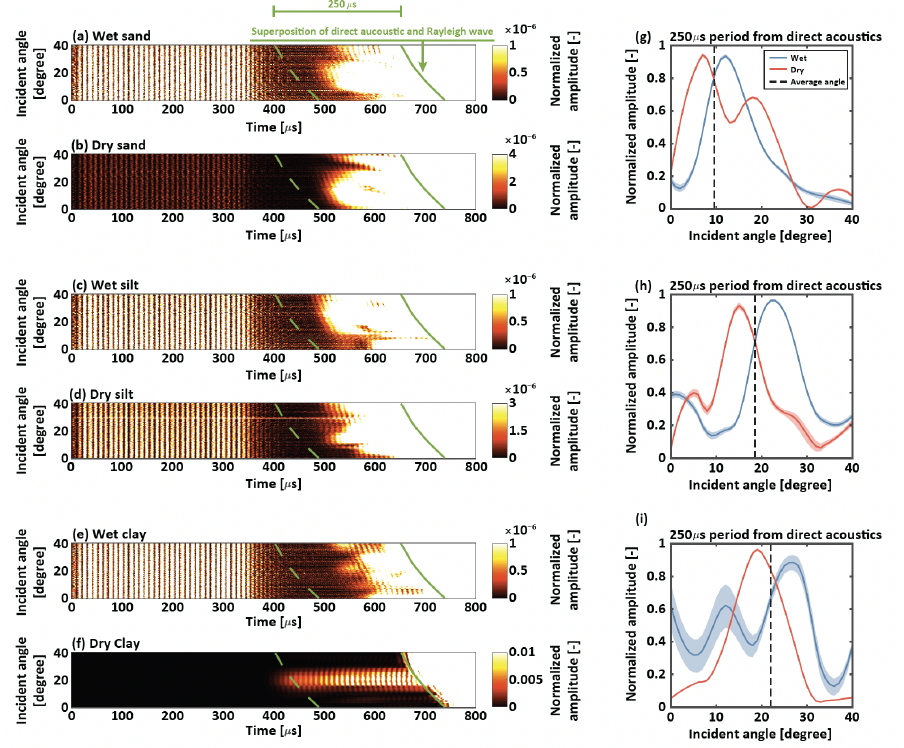
Figure 4. Critical angle experiments. Stacked and superposed ultrasonic signals from the 8 channels under different incident angles (y-axis) for ( a ) wet sand, ( b ) dry sand, ( c ) wet silt, ( d ) dry silt, ( e ) wet clay, and ( f ) dry clay. The hot colors in ( a – f ) represent normalized amplitudes. Here, separate data normalization was conducted under different soil and water conditions for visualization purpose. Averaged normalized amplitudes obtained during 250 µ s from the direct acoustic arrivals are shown for ( g ) sand, ( h ) silt, and ( i ) clay. Red and blue lines represent wet and dry conditions, respectively. The shaded areas in ( g – f ) represent the 20th and 80th